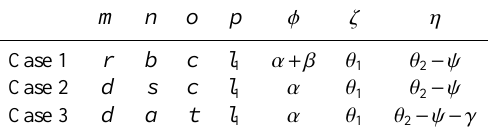
Table 1. Associations of geometric parameters.